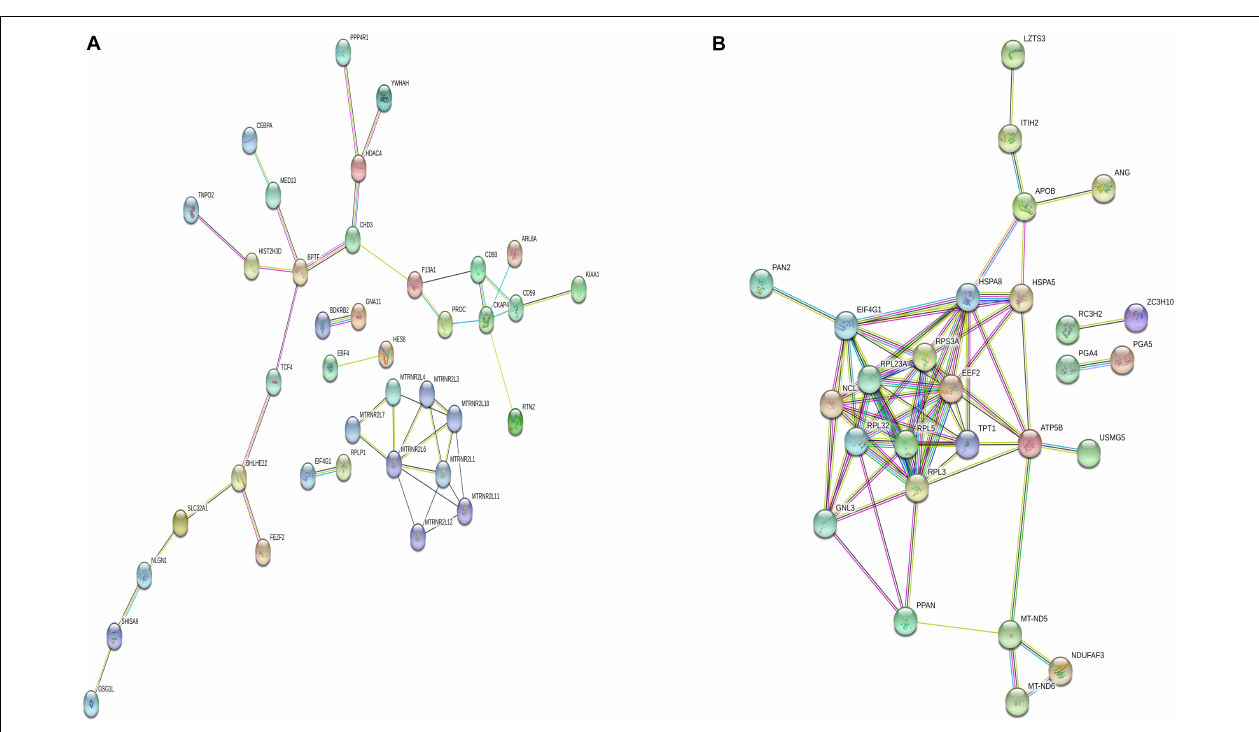
FIGURE 6 | Protein–protein interaction network of DMGs. Disconnected nodes are not shown in the network. (A) total of 81 nodes and 44 edges were established in genes with increased methylation, and (B) 62 nodes and 74 edges were established in genes with decreased methylation. PPI networks both revealed a significantly more